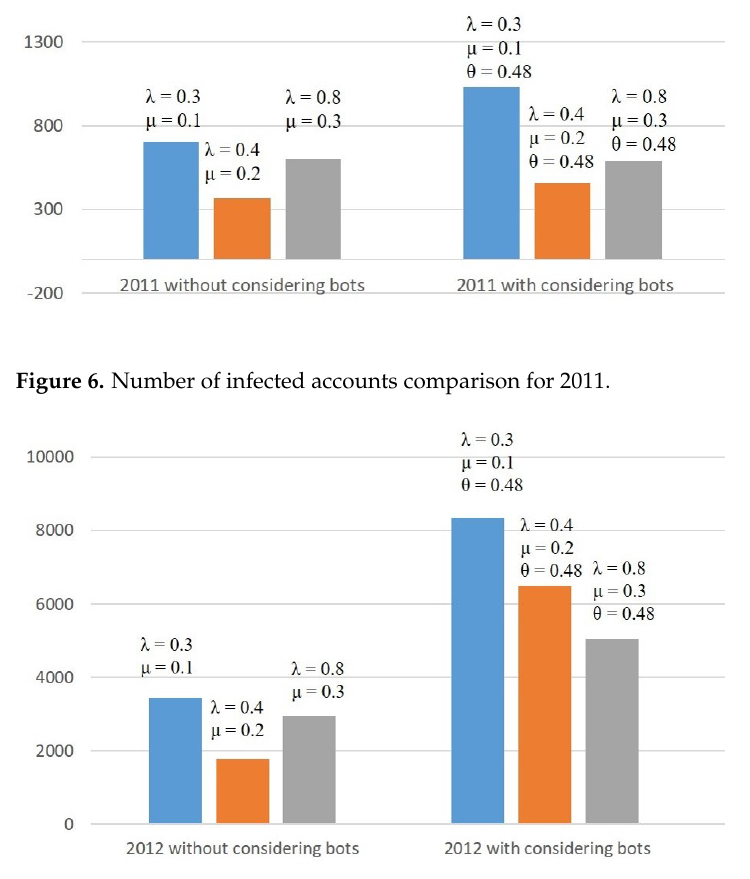
Figure 7. Number of infected accounts comparison for